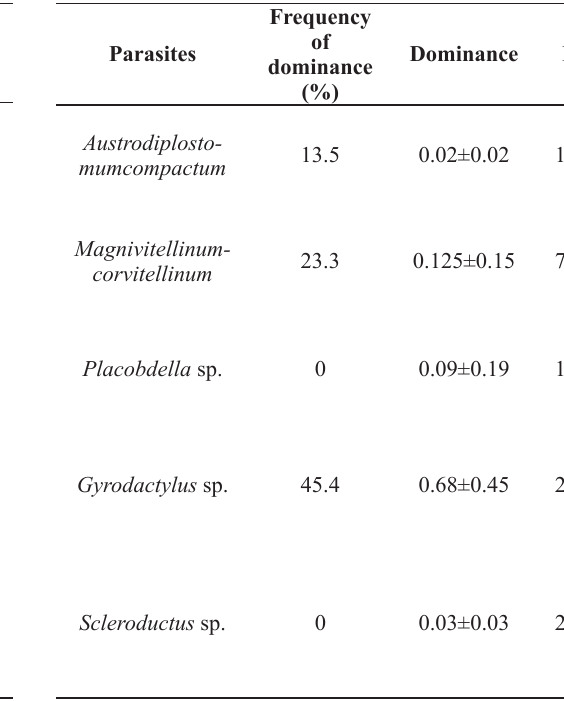
Frequency of dominance, dominance and dispersion index (DI) of the metazoan parasites of Hoplosternum littorale (Hancock 1828), collected in the Lagoa Cabeça de Boi of the Peixe River, Middle Tietê, São Paulo, Brazil.